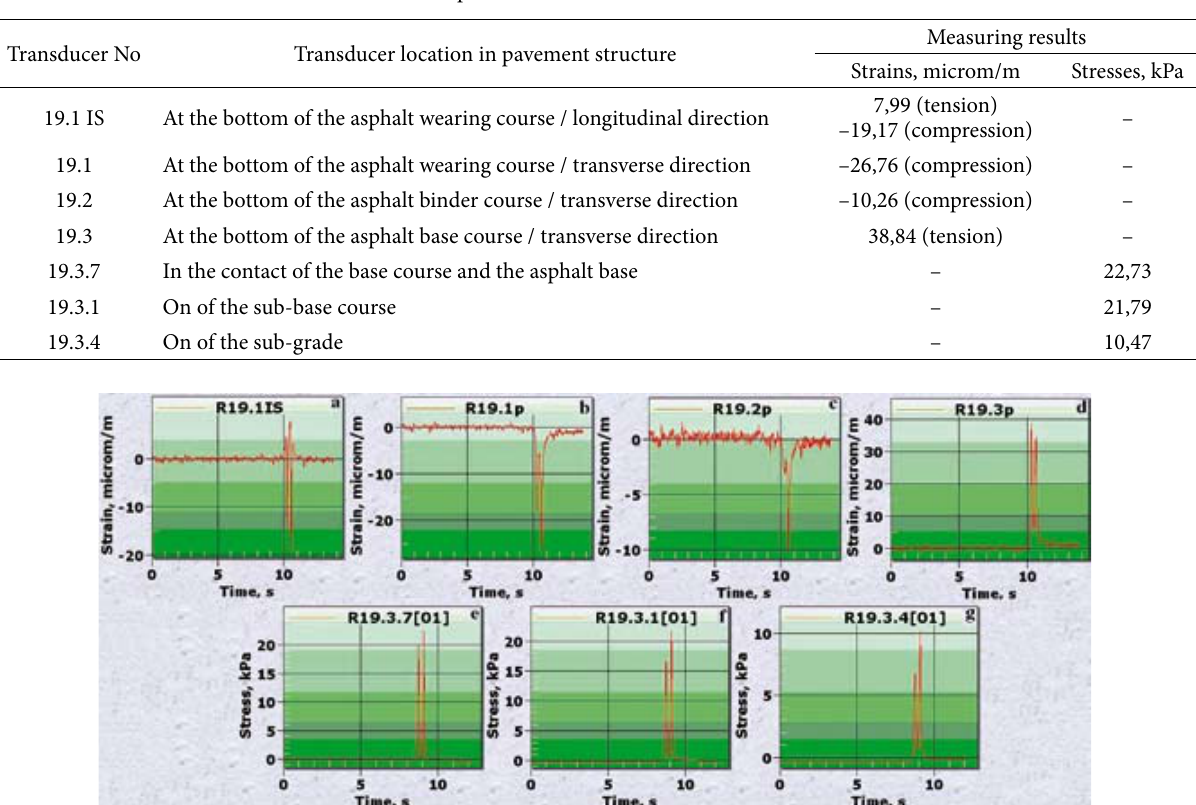
fig. 4. Mean values of equivalent deformation modulus on the asphalt wearing, binder and base courses of different pavement structures of a test road section Table 1. Max values of stress and strain of the main pavement structure of a test section